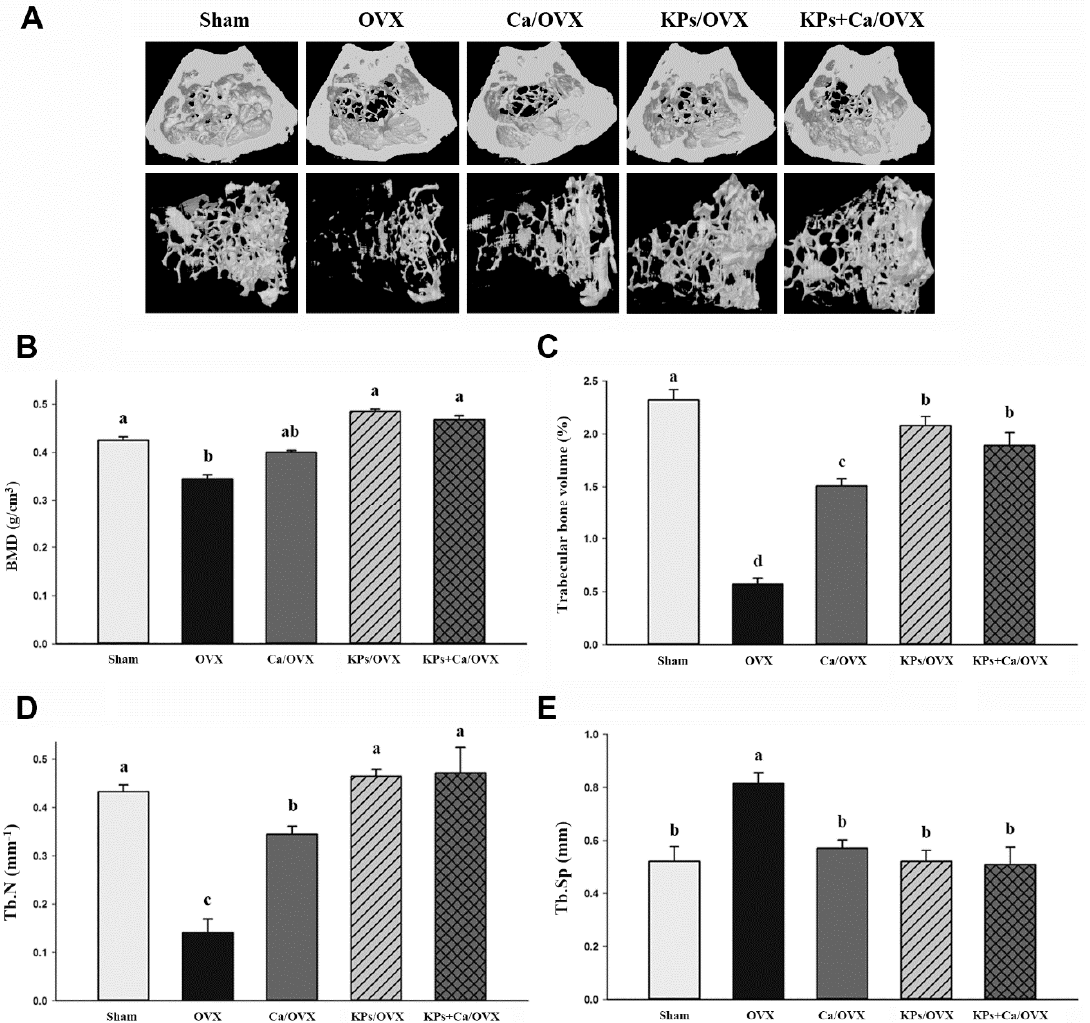
Figure 2. Micro-CT analysis of the femur. ( A ) Three-dimensional images of the distal femur. The images in the upper panel show the transverse section of the femur, and images in the lower panel show the structure of the trabecular bone. ( B – E ) show the morphological parameters of µ -CT analysis, including bone mineral density ( B ), trabecular bone volume (Tb. BV / TV) ( C ), trabecular number (Tb. N) ( D ) and trabecular separation (Tb. Sp) ( E ). The data are presented as means ± SEM ( n = 6). Statistical analysis was performed by one-way ANOVA and Duncan’s post hoc test, and statistical significances are indicated by different letters (a, b, c; p < 0.05).